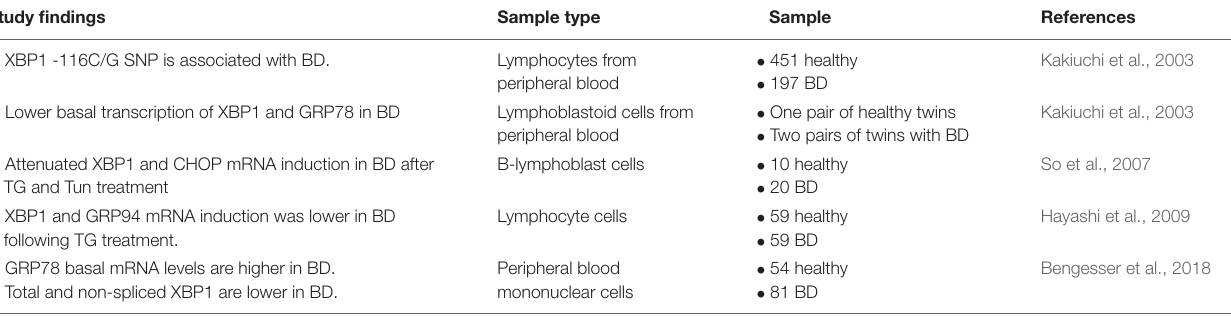
TABLE 1 | Findings relevant to the role of UPR function in bipolar disorder.